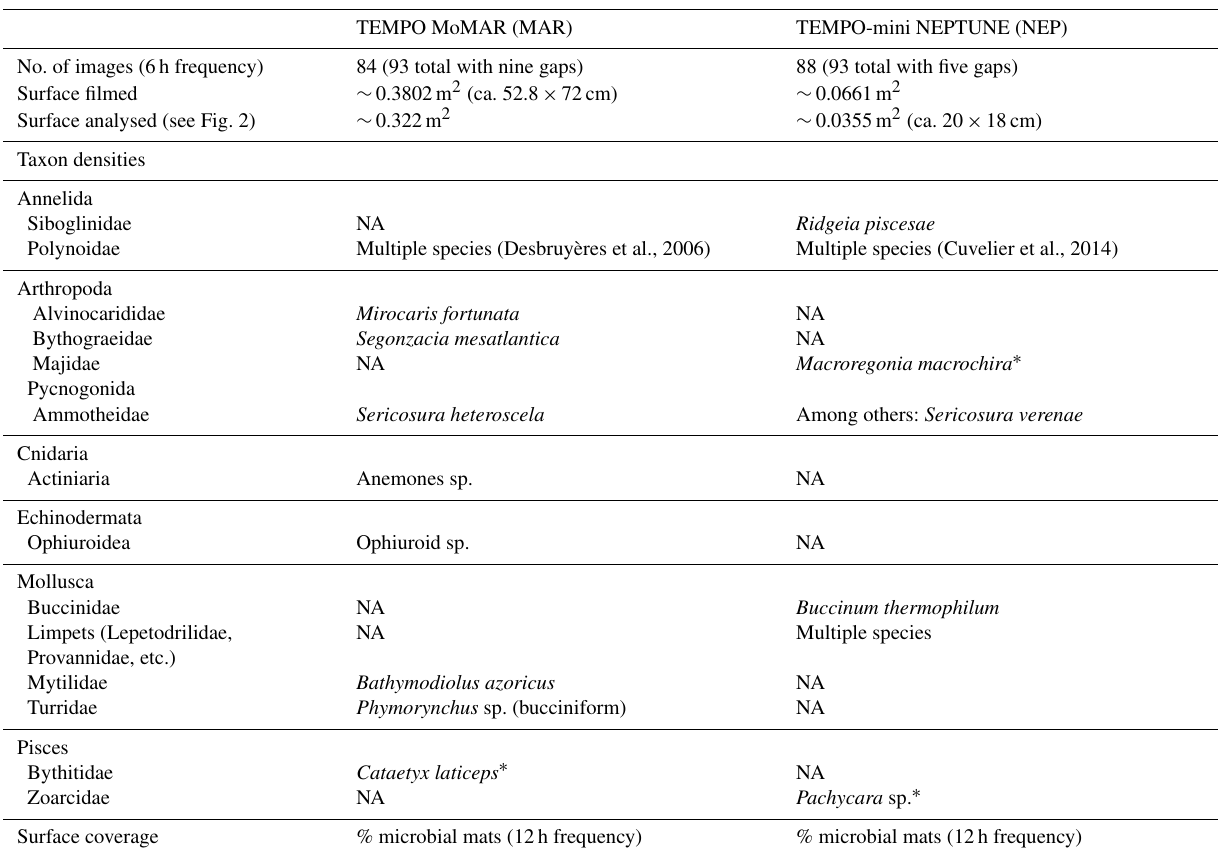
Table 2. Overview of the characteristics of the images analysed such as surface covered and taxa assessed within the FOV. The analysed surface on the MAR is about 10 times larger than that on the NEP. Gaps are failed or unusable video